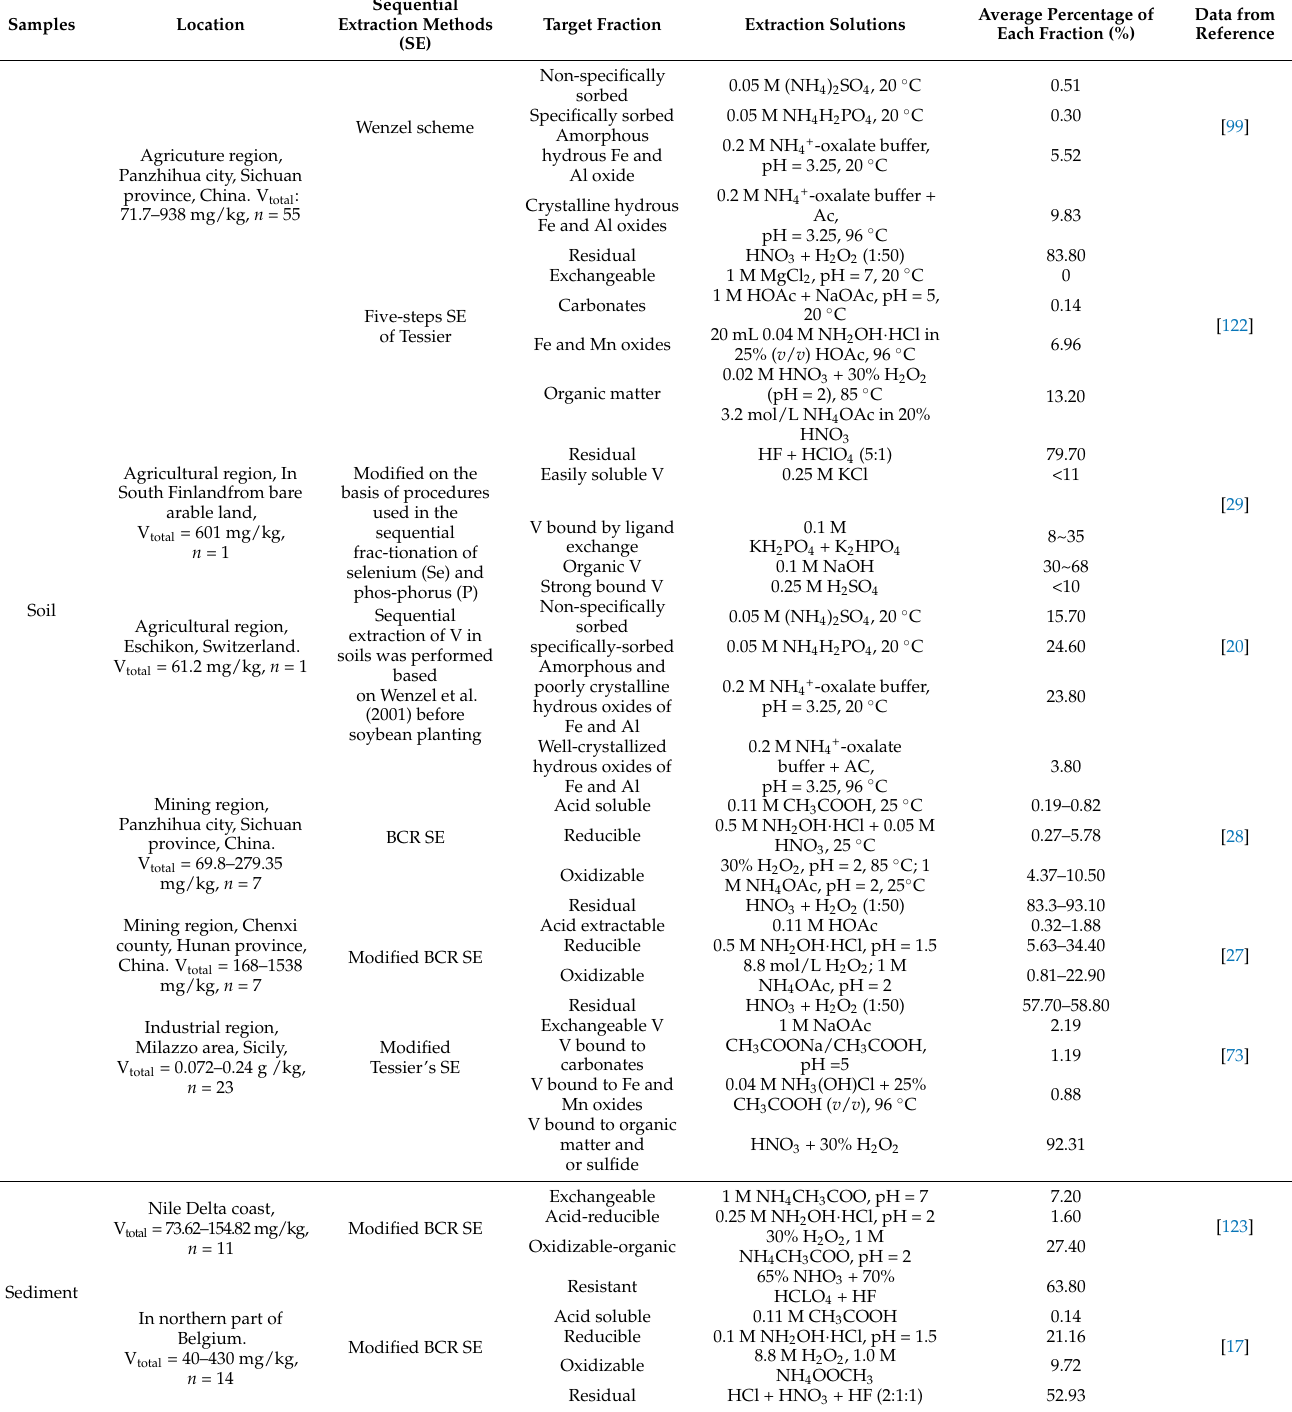
Table 4. Comparison of the V extracted from different environment samples by sequential extrac- tion